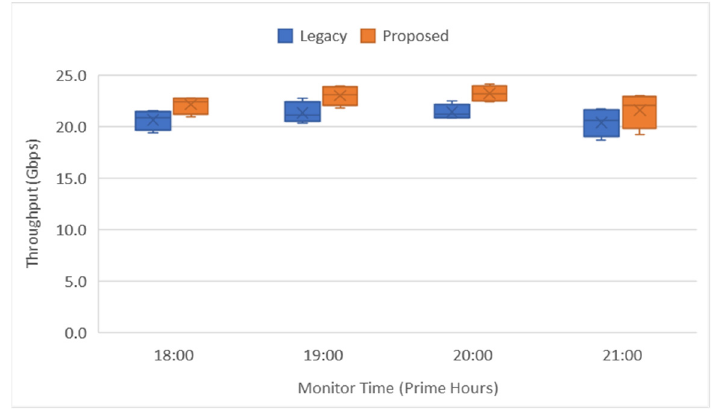
Figure 14. Border leaf switch throughput—All week comparison (input rate).